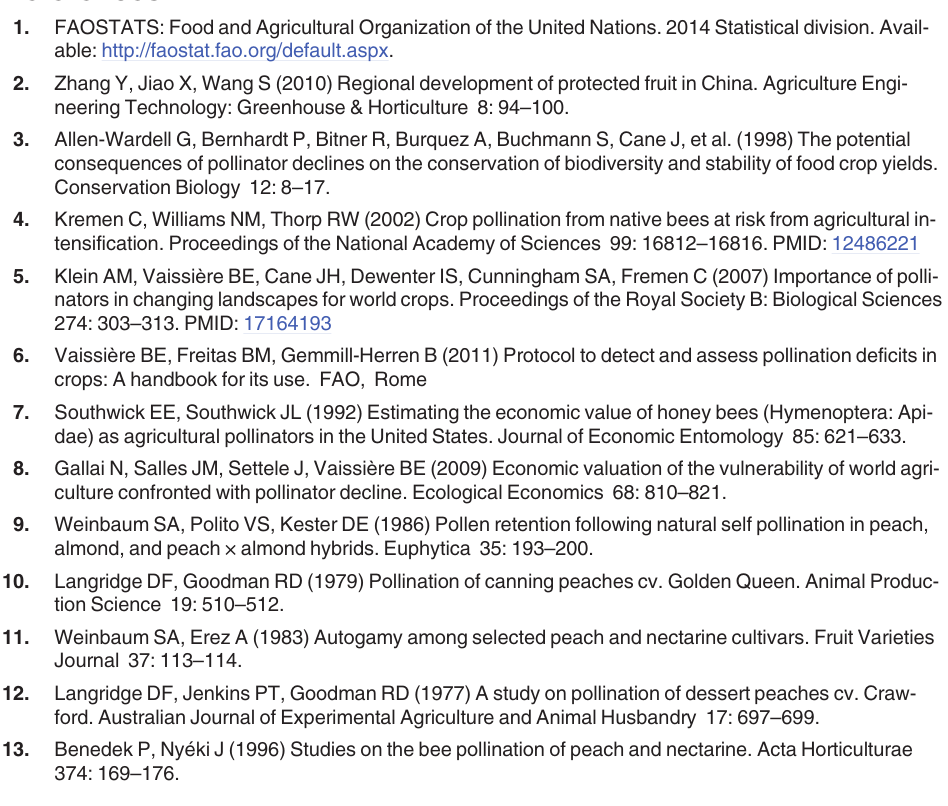
S1 Table. Comparation of pollen tubes lengths, from pollination to days later, in flowers by a single visit of A . mellifera and B . patagiatus by group t-test. S2 Table. Comparation of ovary diameter, from pollination to 15 days later, in flowers by a single visit of A . mellifera and B . patagiatus by group t